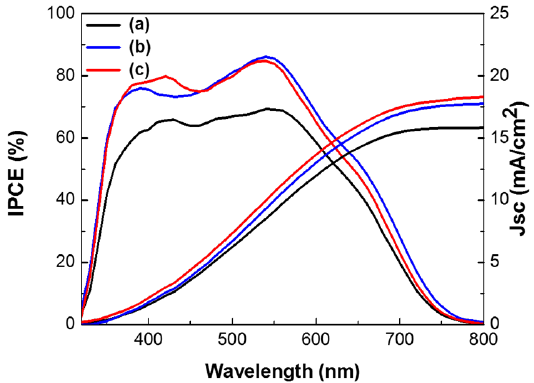
Figure 7. IPCE spectra and integrated current density of the DSSCs based on the layer-by-layer structure: ( a ) without metal NPs, ( b ) with spherical Ag and Au NPs, and ( c ) with multi-shaped Ag and Au NPs.